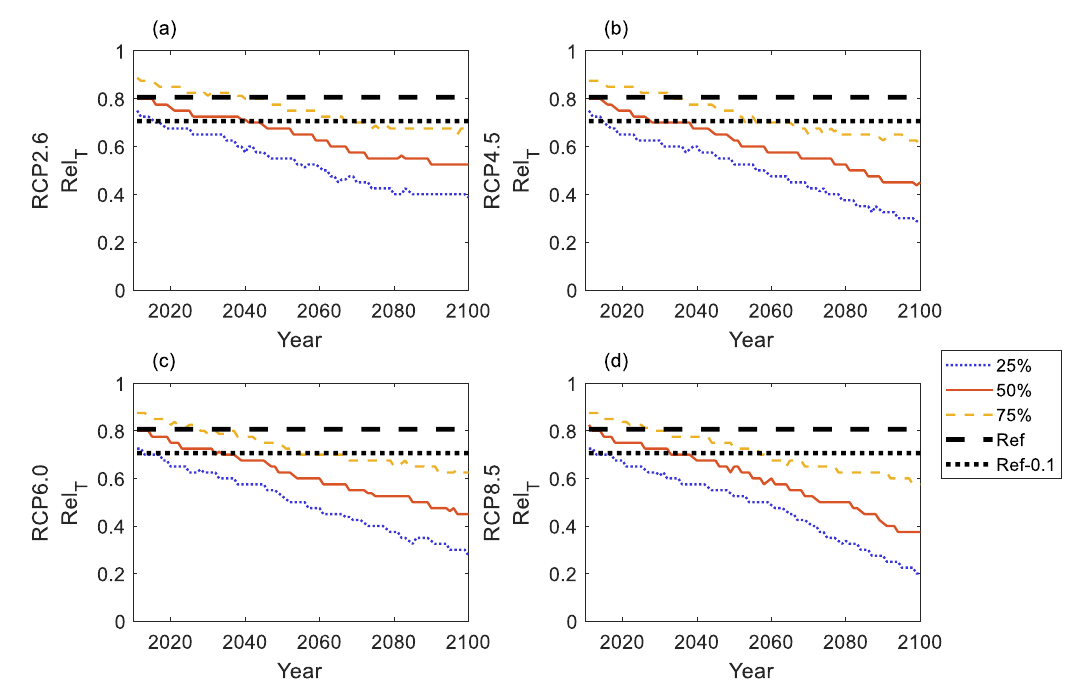
Figure 6. Time-based reliability under RCP 2.6 ( a ), 4.5 ( b ), 6.0 ( c ), and 8.5 ( d ) for a 40-year moving window, with the horizontal axis being the last year of the window. The thick dashed and dotted lines represent the reference historical performance and 10% worse-than-the-reference value, respectively.